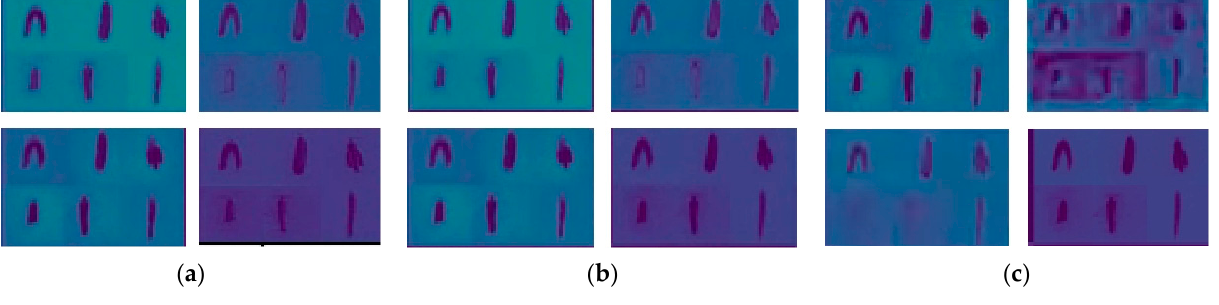
Figure 10. Model features visualization of part layers. ( a ) Features of the teacher network; ( b ) Features of student network with supervision; ( c ) Features of student network without supervision.